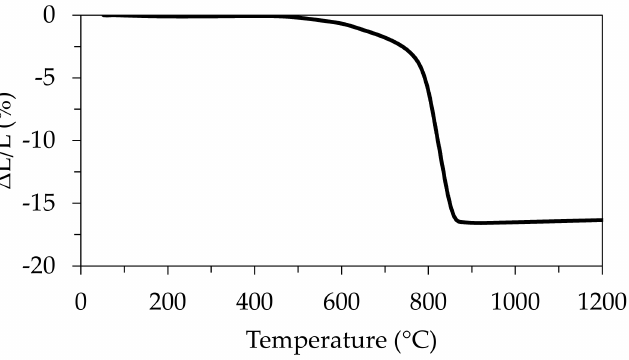
Figure 7. Dilatometric behaviour of the green sample printed from the paste containing 35 vol.% bioactive glass.